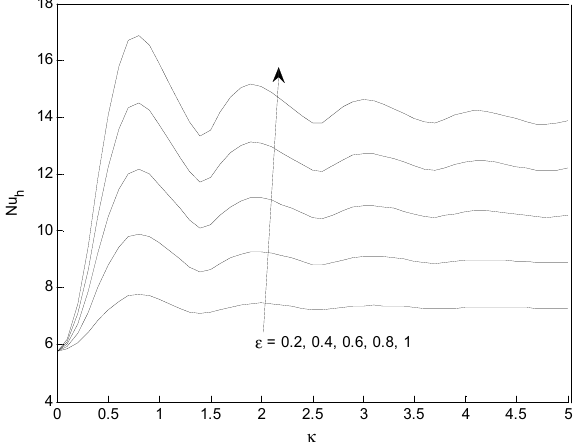
Figure 9. Profiles of average Nu with κ and ε for a stationary case at Ra = 10 6 , Pr = 7, ϕ = π /3.